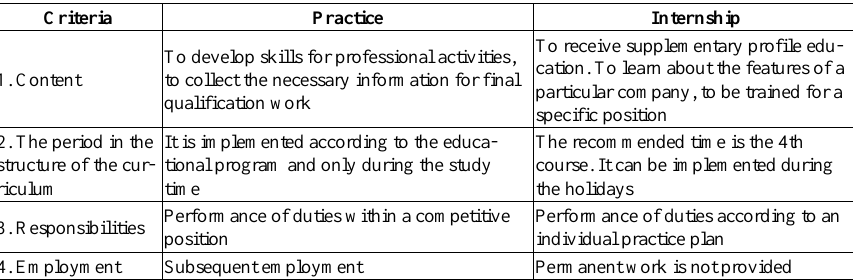
Table 1. Criteria for comparing practice and internships